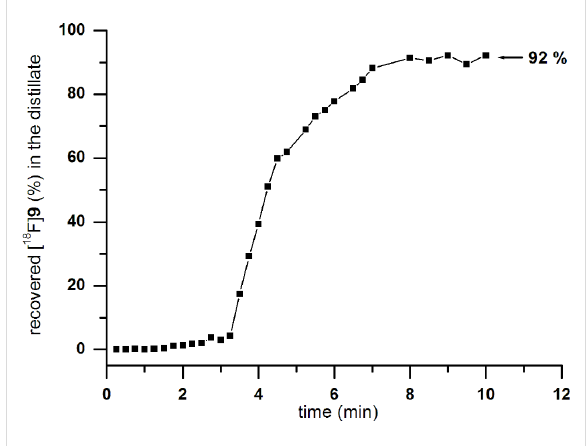
Figure 4: Time course of the distillation of 3-[ 18 F]fluoropropyl thio- cyanate ([ 18 F] 9 ) in the argon stream. For calculation of the distillation yield only the fraction of [ 18 F] 9 in the crude mixture is